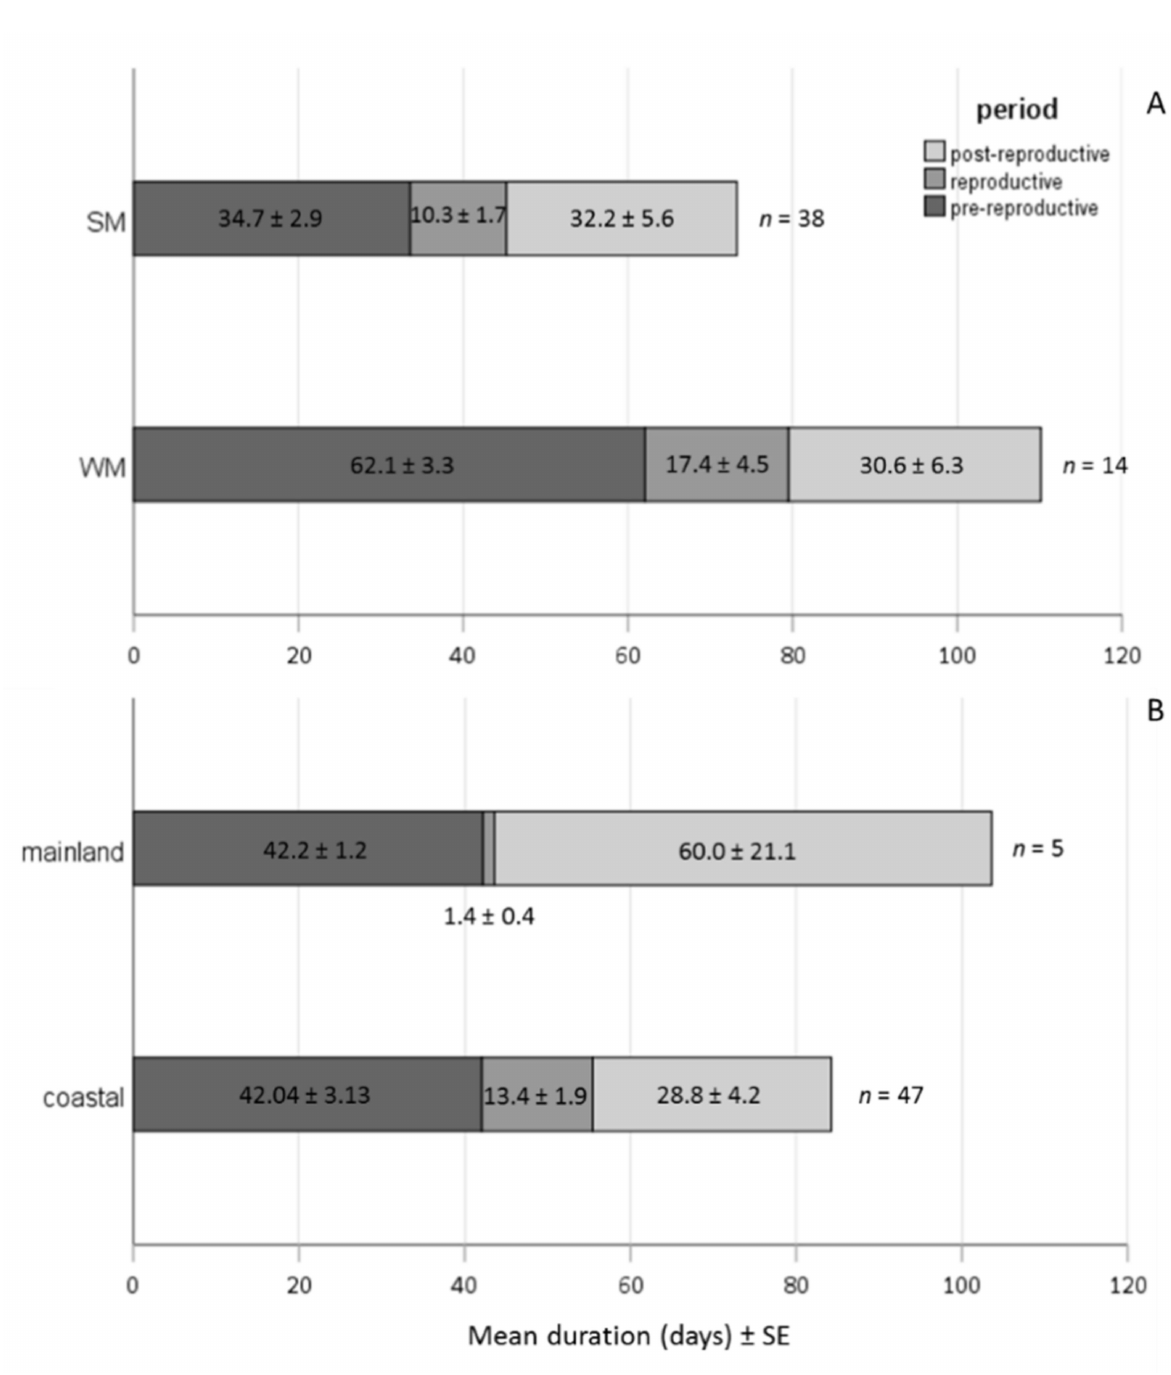
Figure 7. Bars depicting the mean duration of pre-reproductive, reproductive and post-reproductive periods of SM and WM females regardless of the overwintering area ( A ) and of females exposed in the mainland (Naousa) and the coastal (Volos) area, regardless of their phenotype ( B